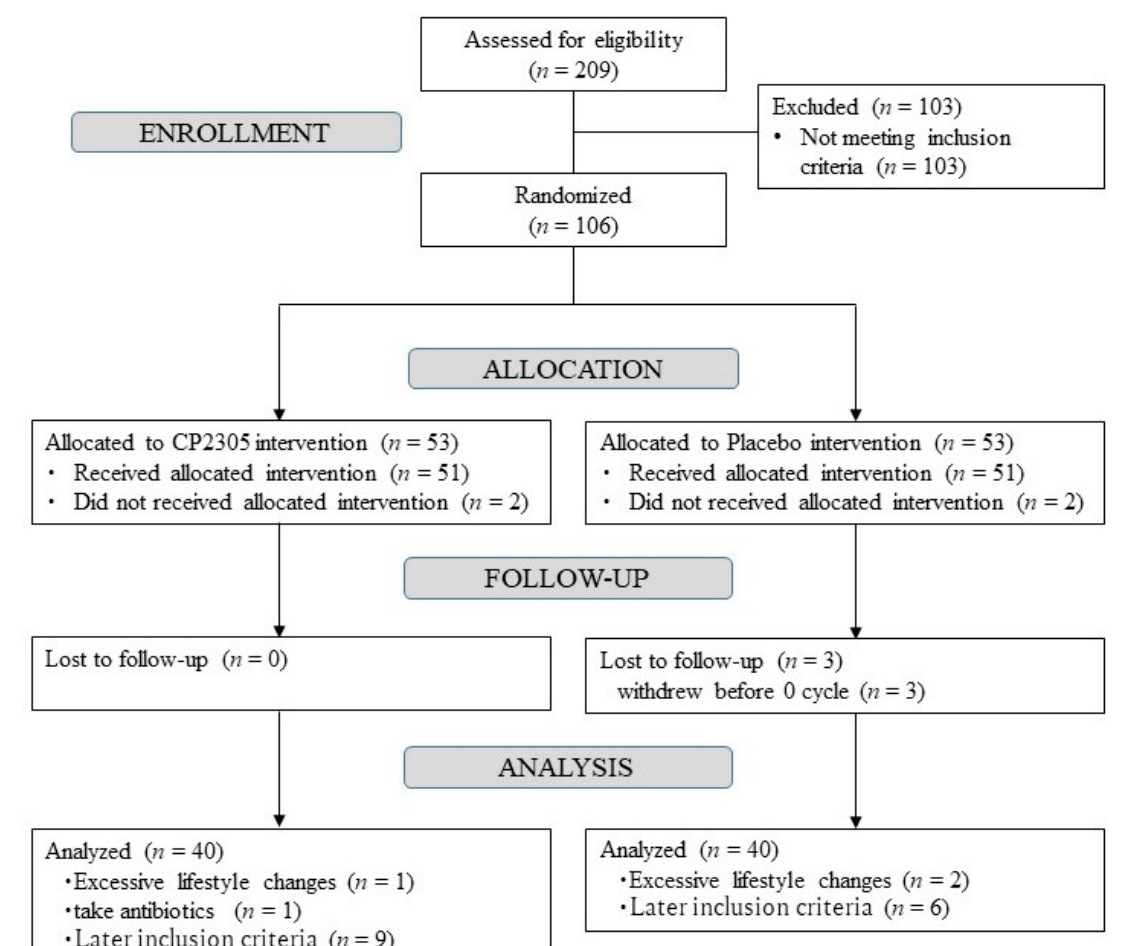
Figure 1. Flow chart of the selection process based on the inclusion/exclusion criteria of the subjects enrolled in the study. The subsequent inclusion criteria are that the diary entry did not meet the inclusion criteria before ingestion. CP2305, Lactobacillus gasseri CP2305. After the intervention, 19 participants were excluded—15 had an abnormal menstrual cycle before registration depending on their diary, 3 had excessive changes in exercise or dietary habits, and 1 consumed antibiotics. Finally, the analysis was conducted with 80 participants—40 each in the CP2305 and placebo groups. There were no significant differences in age, BMI; menstrual cycle; menstrual period; levels of E 2 , FSH, and Equol; or SMI total score between the CP2305 and placebo groups before the start of ingestion (Table 2). No adverse events were observed in any of the subjects, including the excluded ones, throughout the trial. The mean compliance rates were 99.7% for the placebo and 99.8% for the CP2305 groups (no significant difference by the χ 2 test). Medication was ascertained by logbooks, and except for one person who was a regular antibiotic user who was excluded from the analysis, no daily medication was